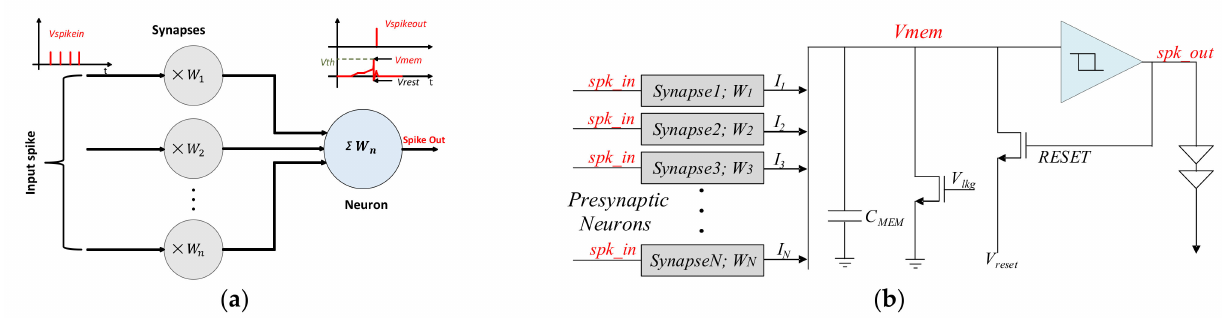
Figure 1. ( a ) Spiking Neural Network Model with a single neuron connected to multiple input synapses; ( b ) Leaky Integrate and Fire Model of the CMOS neuron